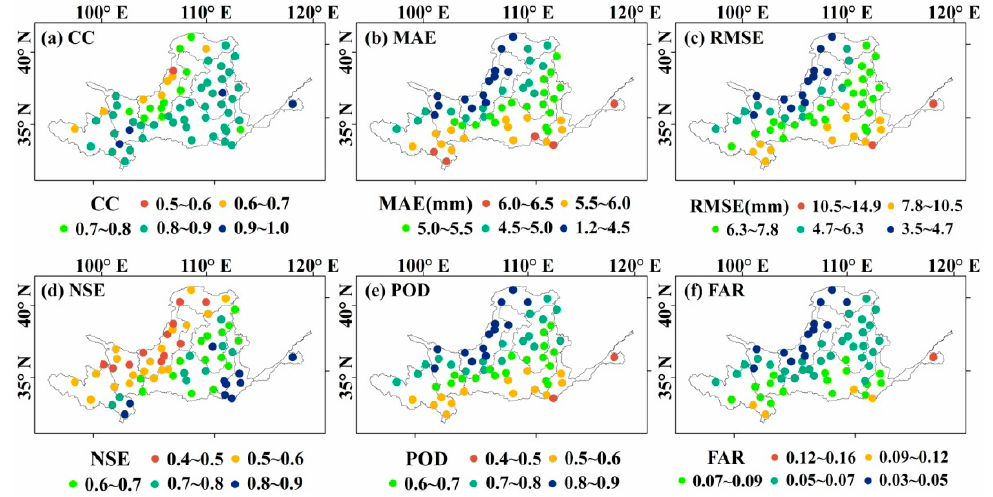
Figure 3. Spatial distribution of six evaluation indicators. ( a – f ) denote correlation coefficient (CC), mean absolute error (MAE), root mean square error (RMSE), Nash–Sutcliffe efficiency (NSE), probability of detection (POD), and false alarm ratio (FAR), respectively.